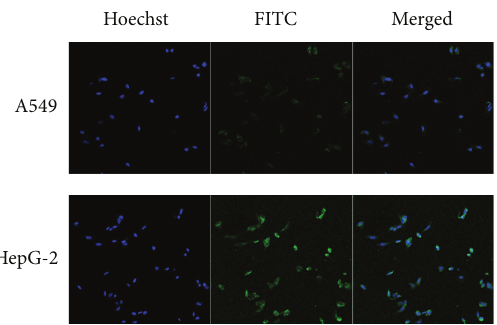
Figure 1: Fluorescence images of HepG-2 cells and A549 cells after the cells were incubated with FITC labeled Gal-CSO/ATP nanoparticles for 24 h, respectively. It is shown that the Gal- CSO/ATP nanoparticles could be uptaken by HepG-2 cells, and the fluorescence intensity in HepG-2 cells was stronger than that in A549 cells. Figure 2: Cellular uptake percentage of Gal-CSO/ATP nanoparti- cles in different cell lines for 12 and 24 h, respectively. It is showen that HepG-2 cells were significantly higher than A549 cells in the cellular uptake percentage of the Gal-CSO/ATP